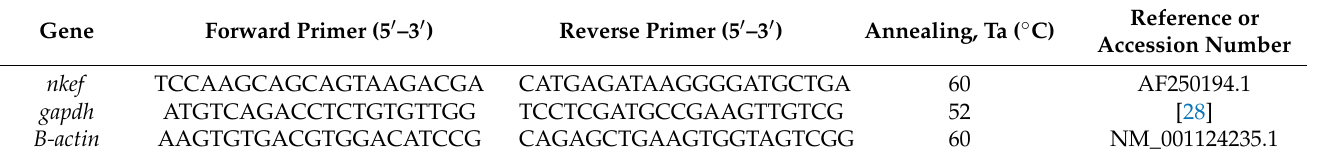
Table 2. Sequences of primers used for